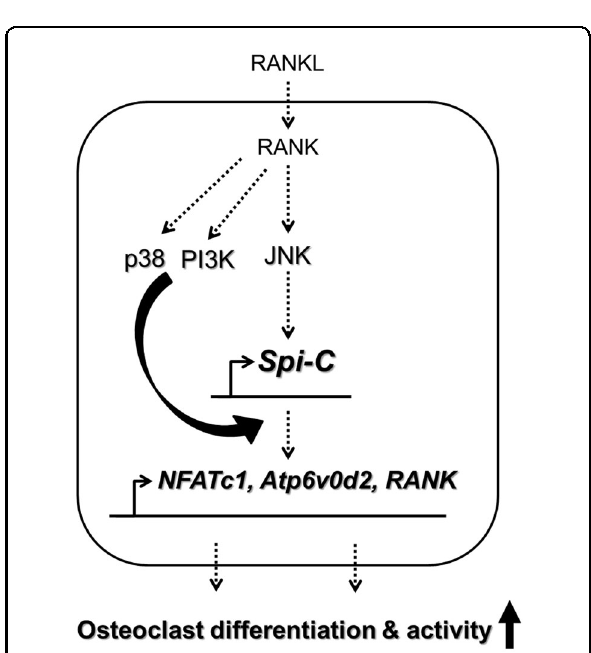
Fig. 8 A proposed model for the role of Spi-C during RANKL- mediated osteoclast differentiation and function. Spi-C is a transcription factor induced by the RANKL-mediated JNK pathway. The activation of p38 MAPK and PI3K by RANKL regulates the nuclear translocation of Spi-C to induce osteoclast marker gene expression, thus increasing osteoclast formation and bone resorption